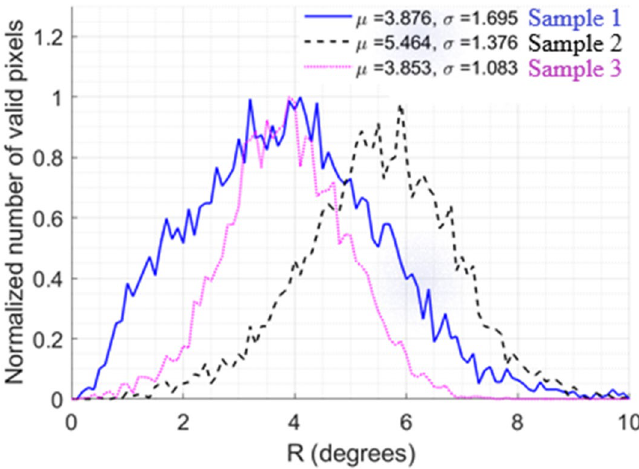
Figure 5. Retardance histograms for the analyzed C + SMC + EC samples based on the measurements within the yellow zone shown in Fig. 3a. µ corresponds to the mean retardance value of an individual sample. σ corresponds to the standard deviation of the mean.